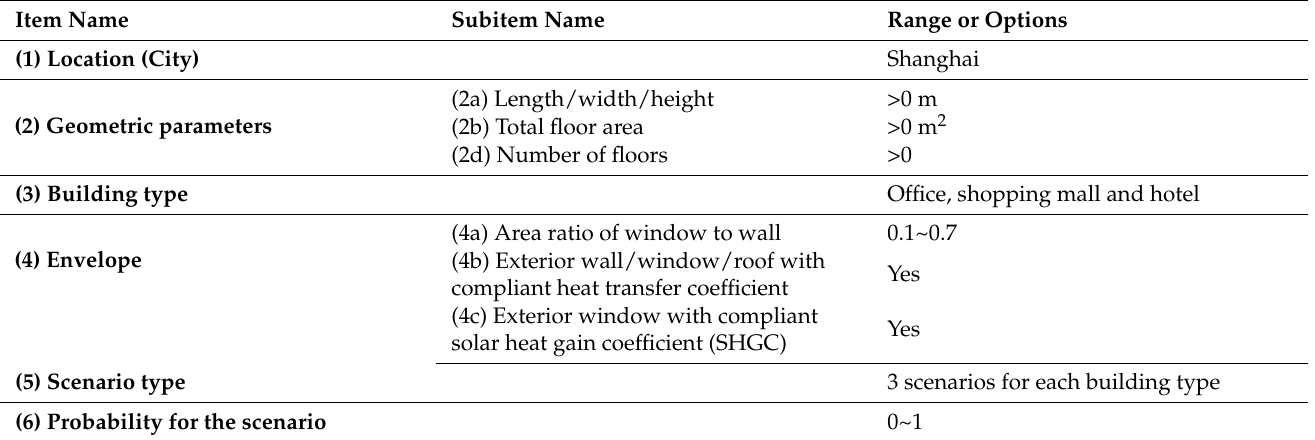
Table 1. Input variables on the UI of the load prediction